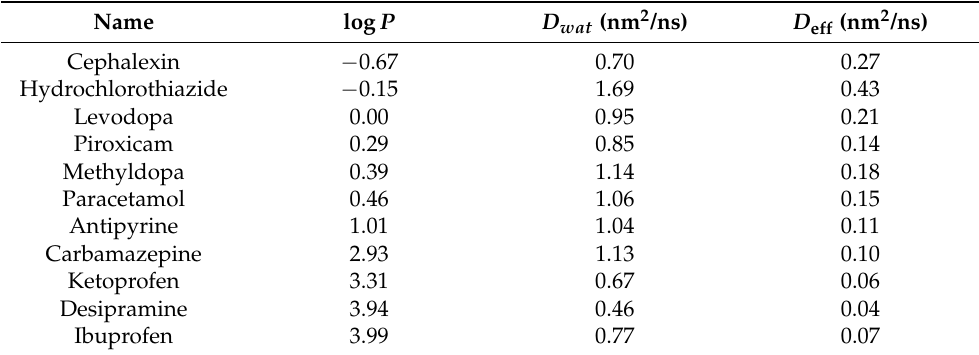
Figure 8. Approximation error on D eff when employing Equation (15) for the toy model ( a ) and the amino-acids simulations ( b ). The error is computed as 100 · predicted value according to Equation (15), and D eff,sim is computed directly from the simulations. Table 1. Estimated values of effective diffusion coefficient for release of various drugs from a lamellar mesophase at 43 ◦ C with geometric parameters chosen from the literature. The values of D wat were obtained by renormalizing experimental values obtained at different temperatures via the Stokes– Einstein equation, as discussed in the Methods [57]. Experimental values of D wat and log P were taken from Refs.